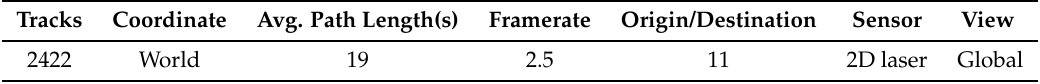
Table 1. Properties of data used for trajectory